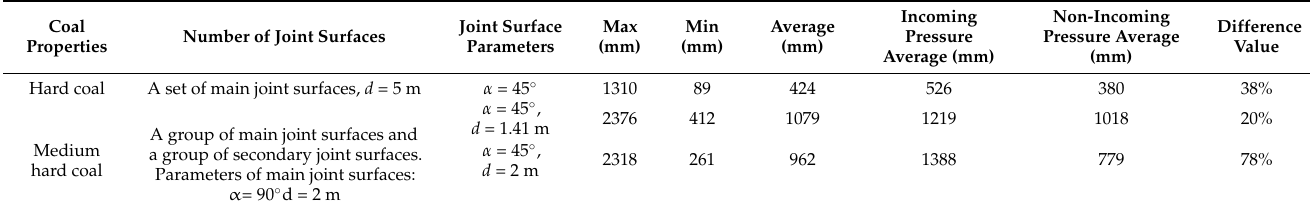
Table 9. Coal wall Y-displacement in different joint spacings ( α = 45 ◦ ).